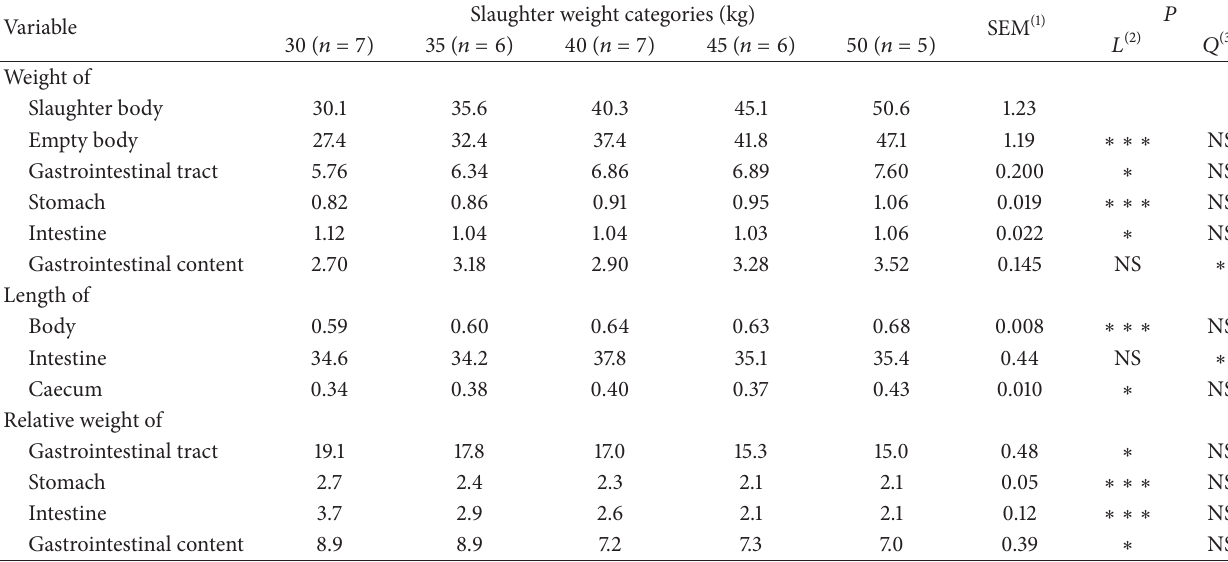
Table 2: Slaughter body (SBW) and empty body (EBW) weights (kg), absolute weights (kg) and length (m), and relative weights (% of SBW) of gastrointestinal tract segments of Karayaka ram lambs.